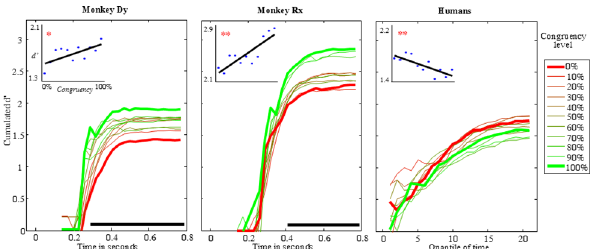
Fig 4. Cumulated d ’ as a function of time in the “ Noisy Background ” condition (bins of 30ms in monkeys, quantiles of relative time in humans: mean quantile duration = 20ms SEM +/0.6ms, first quantile starts at 370ms SEM +/- 11ms). The thick red and green lines represent 0% and 100% congruency levels (respectively), while intermediate levels are depicted with thin lines. The horizontal black line indicates the significance of the difference between extreme congruency level trials (permutation test, 1000 permutations, α < 0.01). Inserts on top left represent linear regressions of total cumulated d ’ as a function of congruency level. Blue dots are observed values and black lines are the linear regression. Slopes, R 2 and p-values are respectively s Dy = 0.026, R 2 Dy = 0.45 p Dy = 0.024, s Rx = 0.054, R 2 Rx = 0.72, p Rx = 0.001, s H = -0.027, R 2 H = 0.58, p H =